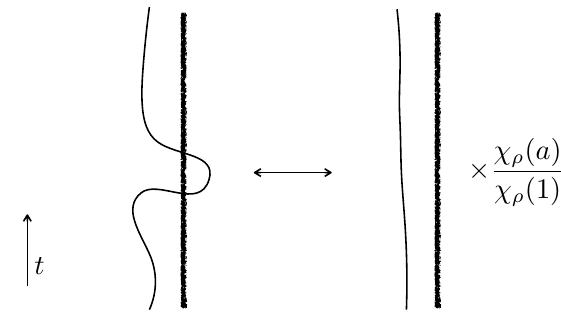
Figure 2 . Cross-section of a particle worldline going around a vortex; the time direction is shown, and the ( d − 3) spatial directions along which the vortex extends are suppressed. The fact that the particle winds around the vortex means that the corresponding Wilson line and Gukov-Witten operators are linked, in the Euclidean picture. The linking property (2.4) of topological and charged operators encodes the fact that the correlator on the left and right pictures differ by a multiplication by the character of the representation, which is the Aharonov-Bohm